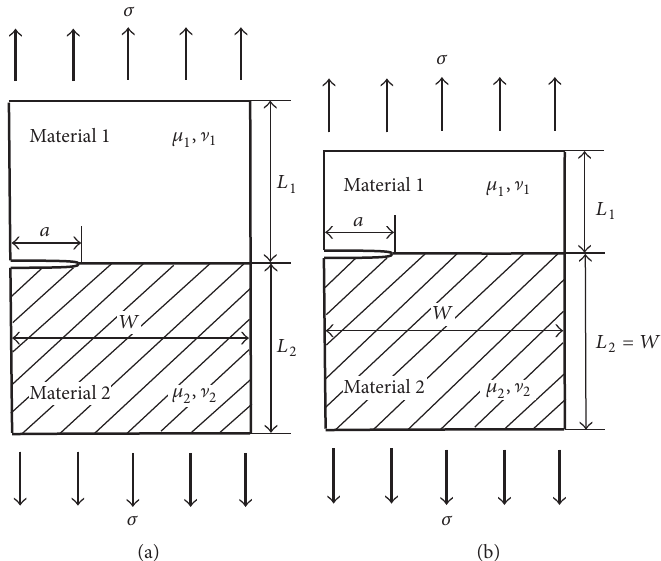
Figure 4: Geometric configurations for (a) longitudinal symmetrically bonded strip and (b) longitudinal asymmetrically bonded strip.